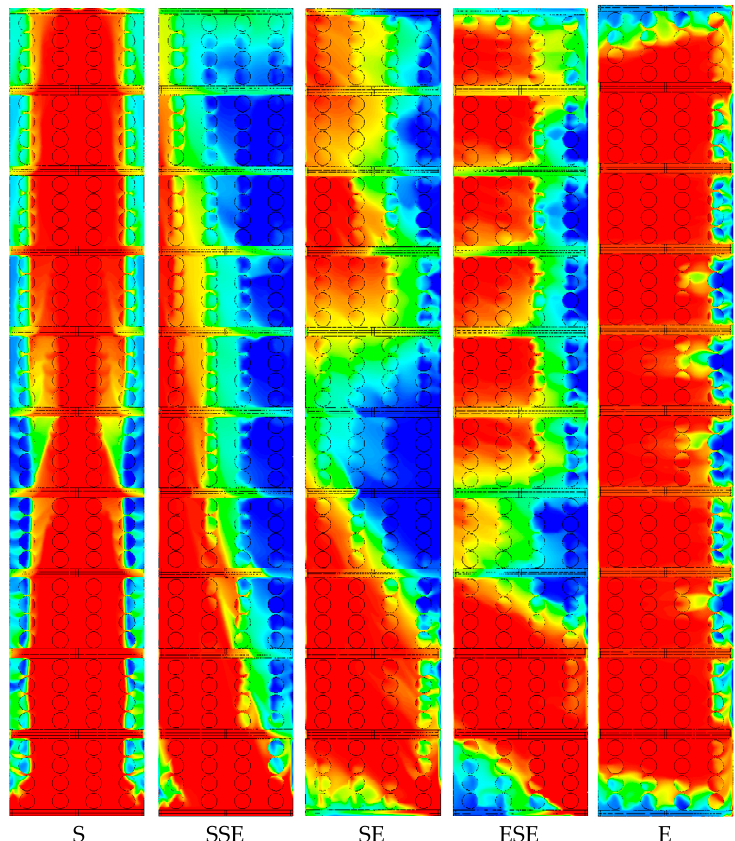
Figure 12. Temperature contour of the evaporators (top side), uniform field and all directions. The corresponding global recirculation ratio for all wind directions is shown in Figure 13. The results have been extrapolated for 360° due to the two symmetry plans of the geometry.